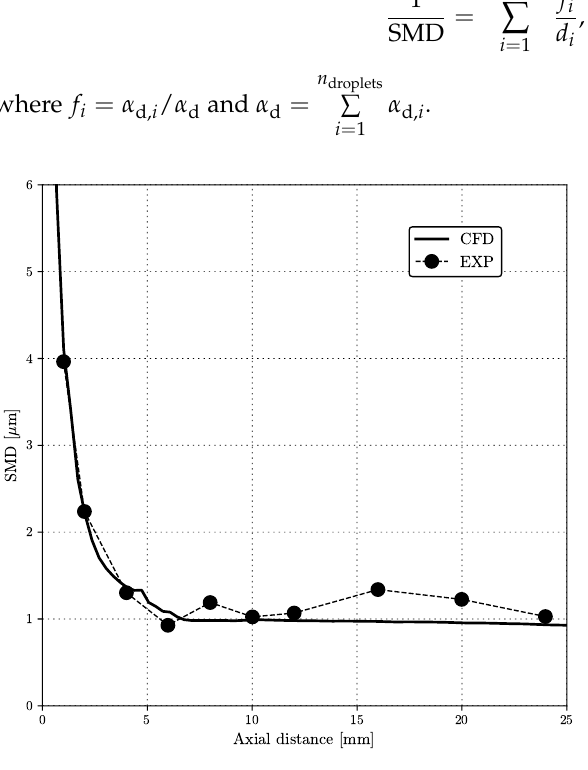
Figure 4. Axial SMD